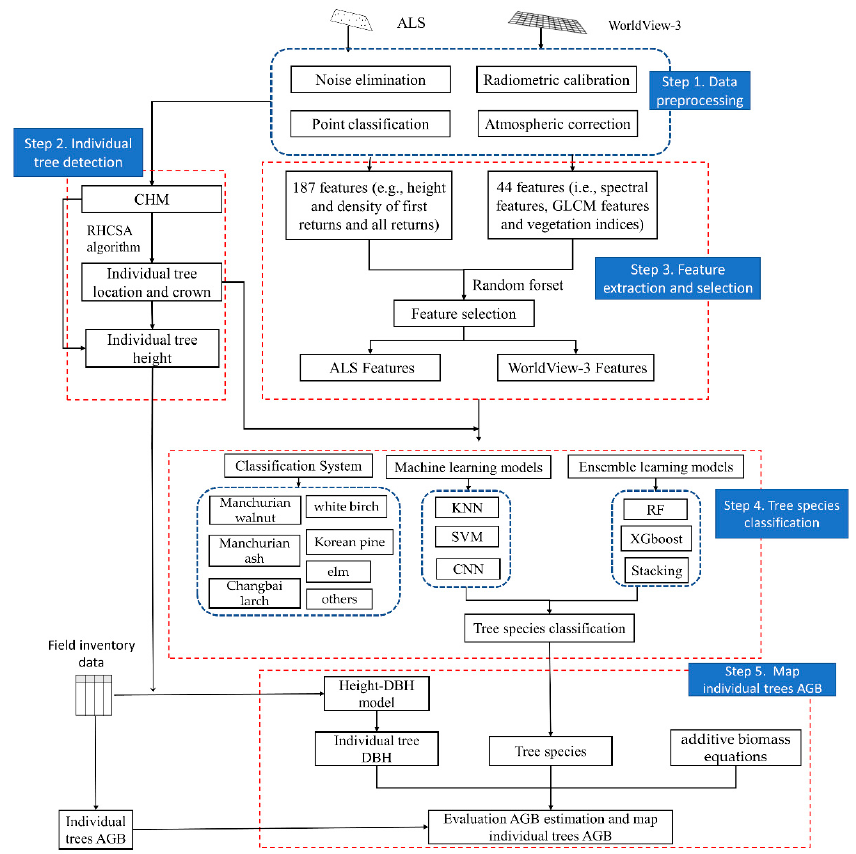
Figure 1. Flowchart summarizing five key steps within this study.